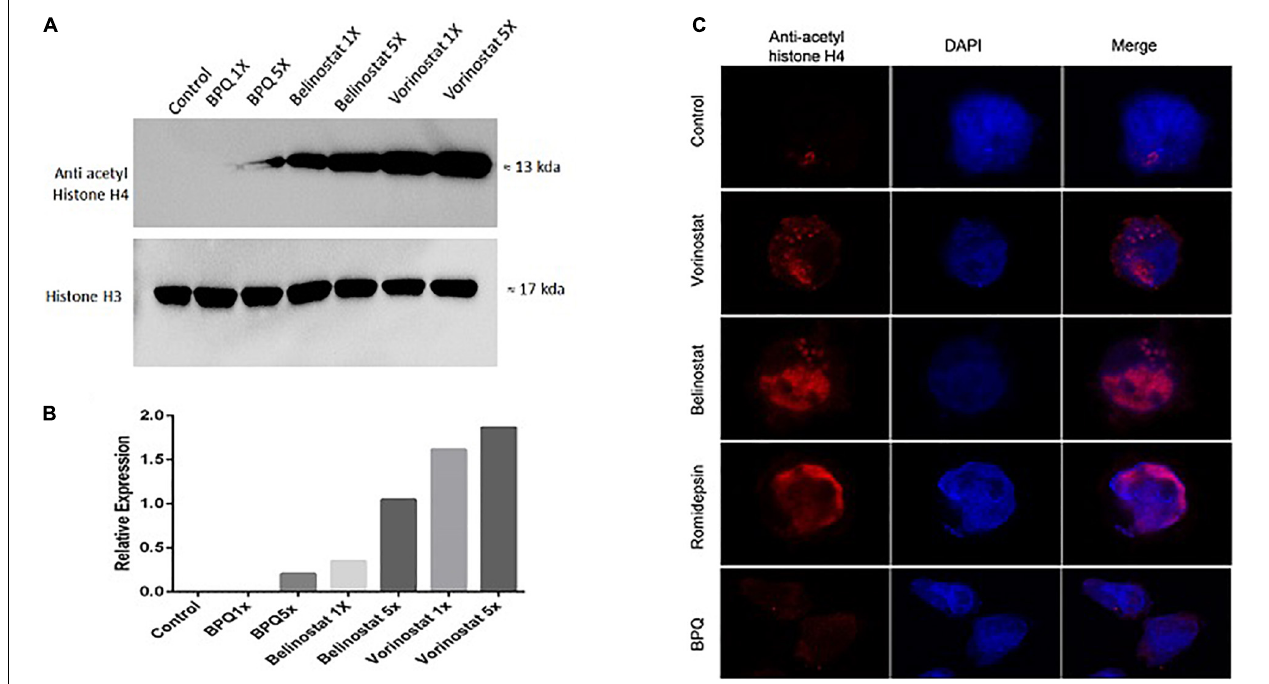
FIGURE 2 | Acetylation profiles of T. annulata infected cells after 3 h of treatment with histone deacetylase (HDAC) inhibitors. (A) Western blot analysis of the T. annulata infected cells treated with 1 × IC 50 and 5 × IC 50 concentrations of different HDACi (vorinostat, belinostat, and romidepsin) and controls (without treatment and with BPQ treatment) using mouse anti- acetyl histone H4 antibody. Histone H3 was taken as the loading control. (B) The graph shows the relative quantification of the H4 as detected in the western blot. (C) Immunofluorescence staining of T. annulata infected cells with 1 × IC 50 HDACi (vorinostat, belinostat, and romidepsin) after 3 h of treatment. BPQ was taken as